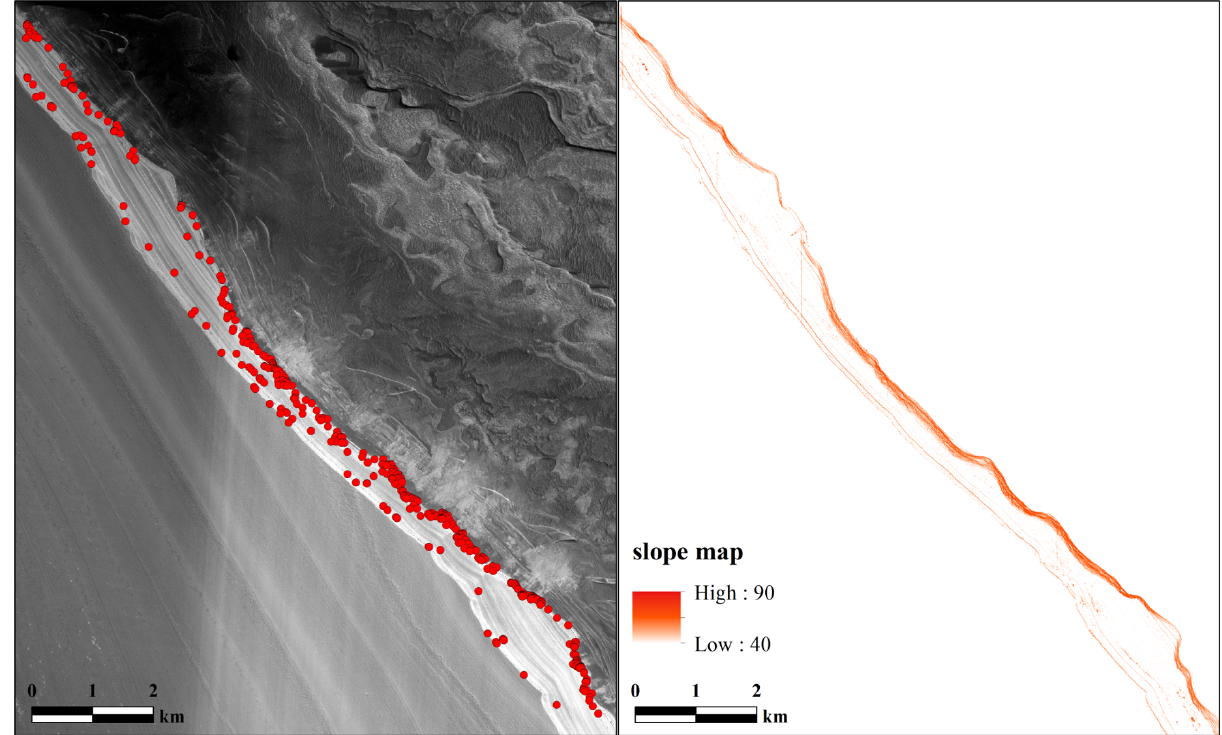
Figure 4. On the left is the change detection result (one red dot corresponds to one area of modified shadow). On the right is the corresponding slope map, only showing slopes above